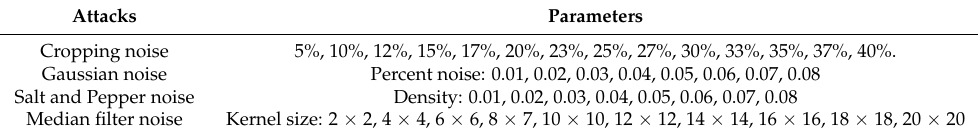
Table 1. Information of the applied attacks Attacks Parameters